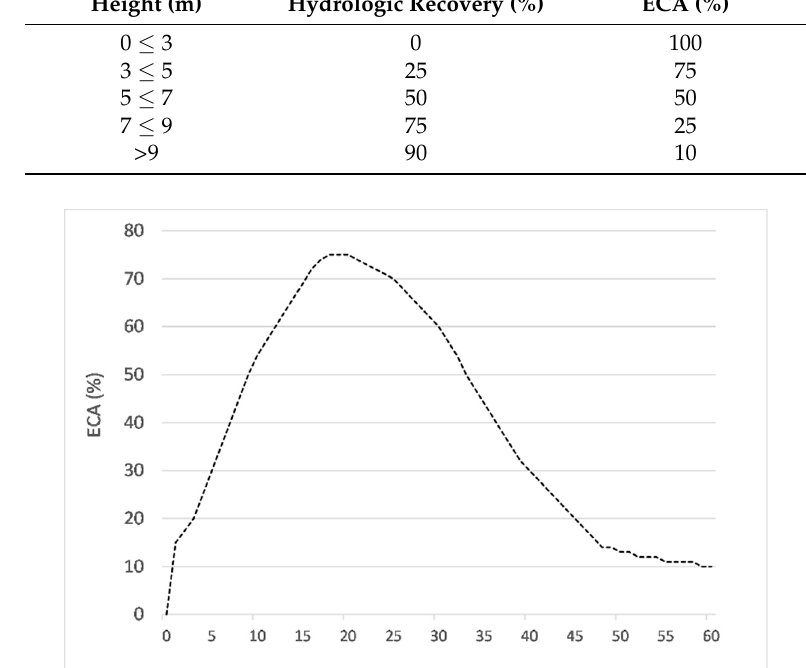
Table 1. Hydrological recovery and equivalent clear-cut area (ECA) for stands disturbed by wildfire or harvesting according to height in meters (m) of the leading tree species.